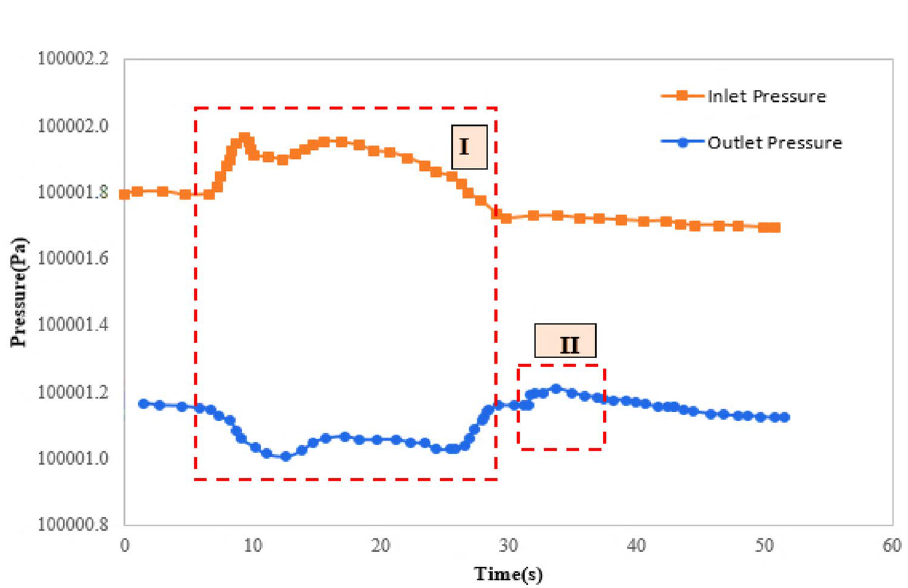
Figure 10. Pressure variations at inlet and outlet of the micromodel for deformation